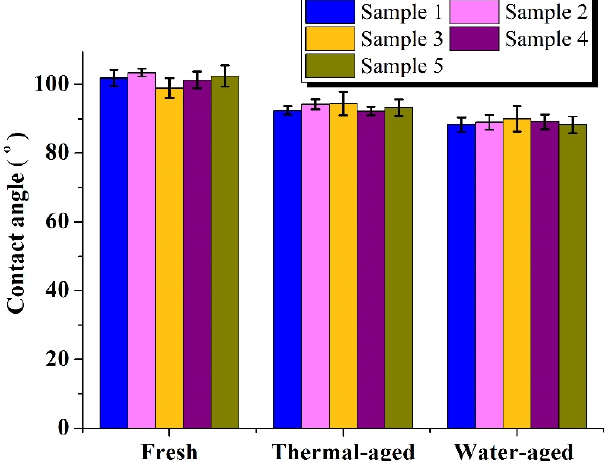
Figure 4. Contact angles of fresh, thermal ‐ and water ‐ aged samples.